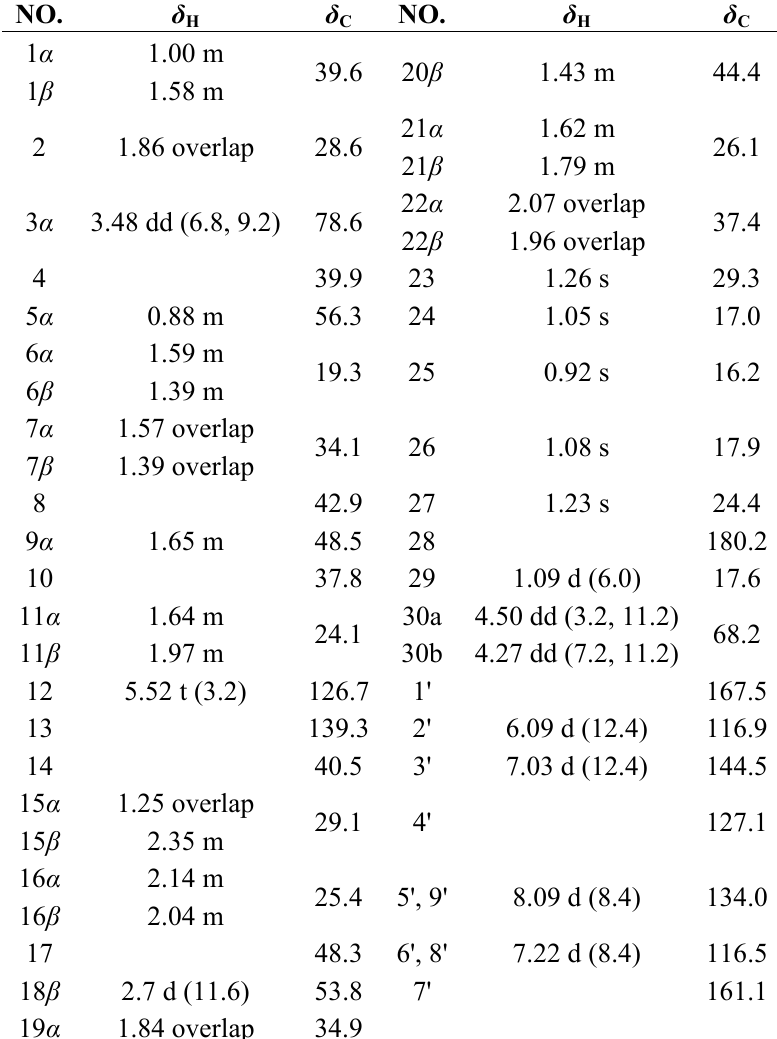
Table 1. 1 H-NMR (400 MHz) and 13 C-NMR (100 MHz) Spectral Data of Compound 1 in D N ( δ in ppm, J in C 5 5